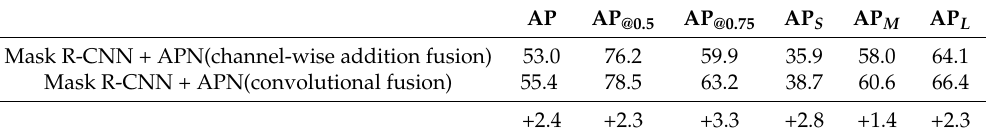
Table 3. The test results of the APN when the channel-wise addition fusion and convolutional fusion are used.